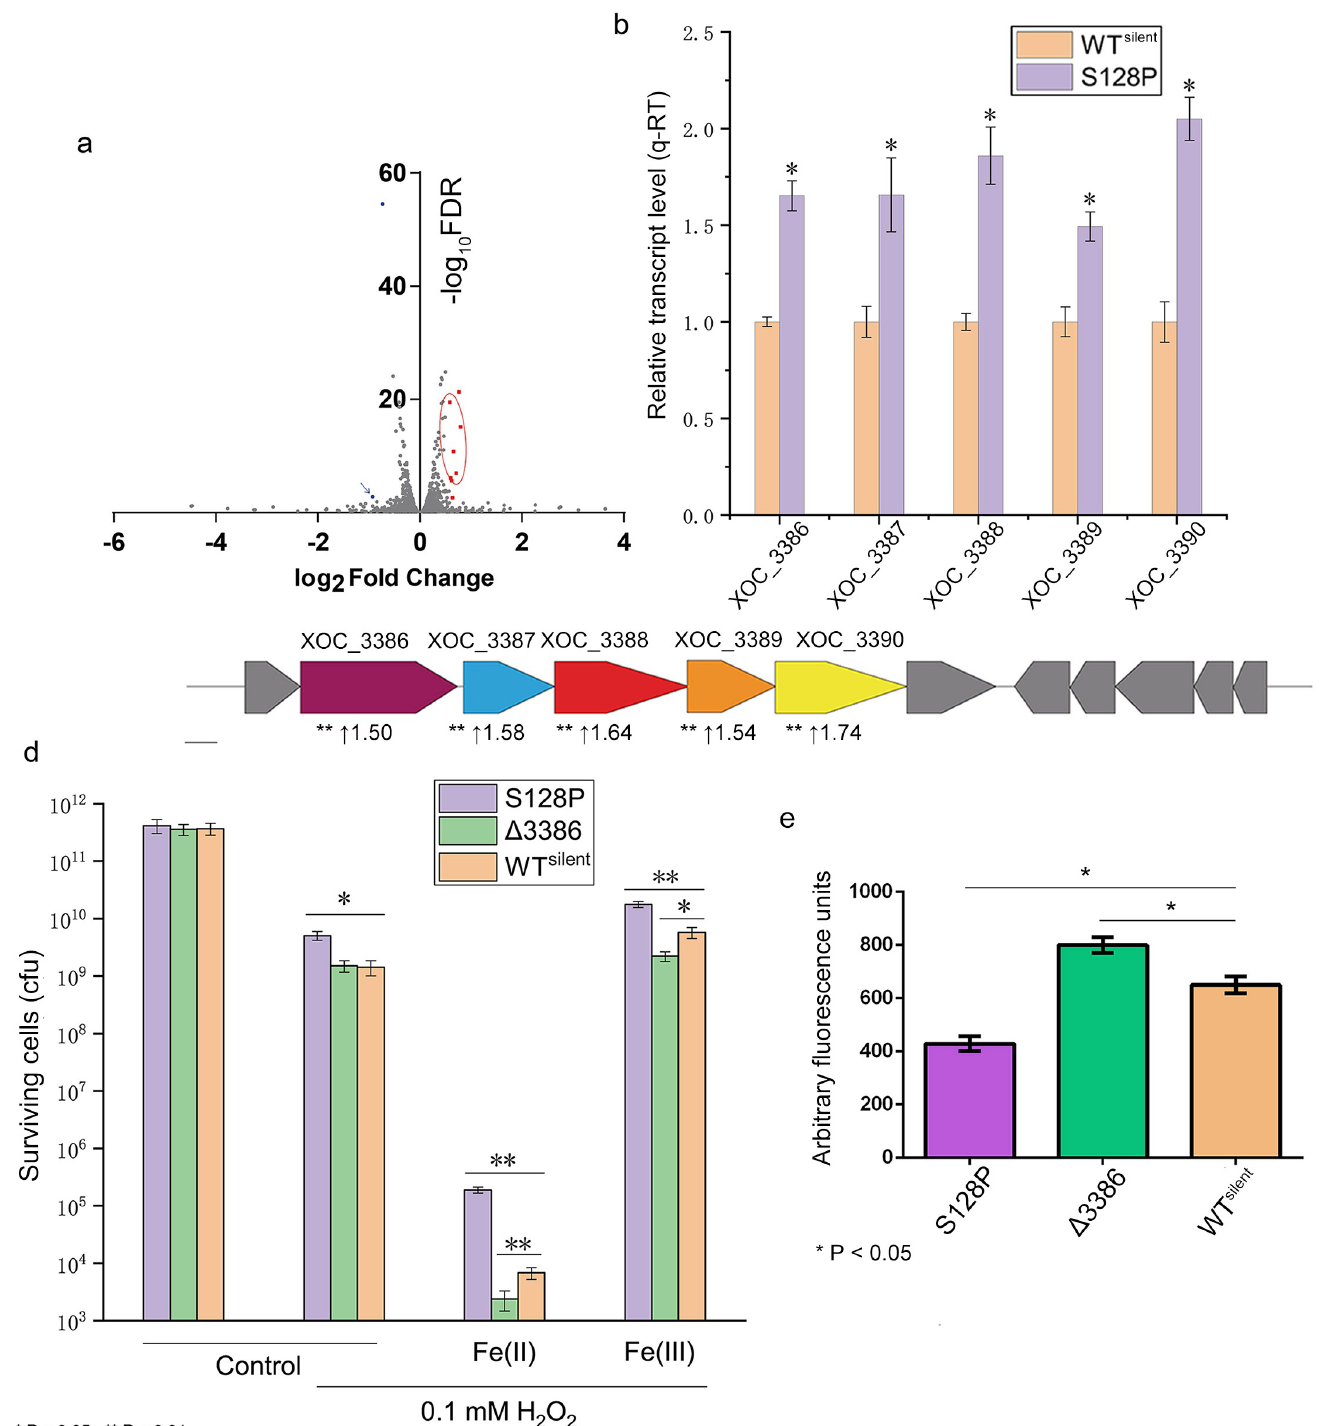
Fig 6. The upregulation of a siderophore biosynthesis gene cluster, which was detected by RNA-seq, contributes to a reduction in the Fenton reaction. (a) Volcano plot showing the FDR P -value and fold change of S128P versus WT. Red dots indicate the upregulated genes with FDR P < 0.01, while blue dots indicate downregulated genes with FDR P < 0.01. Blue arrow indicates XOC_1643, which can cause side effects to S128P as shown in S8 Fig. The circle indicates the gene cluster. (b) Normalized expression levels of target genes were calculated relative to rpoD using the ΔΔ CT method, where CT is the threshold cycle. Four independent biological replicates were carried out in this study. (c) The organization of the gene cluster involved in siderophore biosynthesis. Vertical arrows indicate the upregulated genes in the RNA-seq data. (d) The indicated strains grown to the stationary phase were exposed to 0.1 mM H 2 O 2 by exogenous Fe 2+ and Fe 3+ for 45